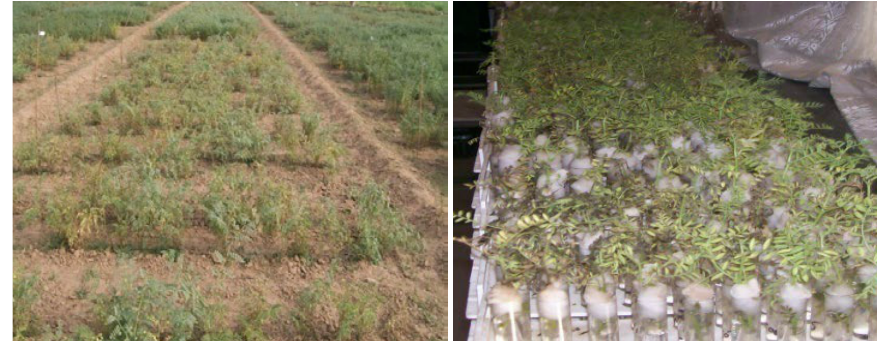
Figure 2. Figure showing screening of wild Cicer accessions under field conditions and laboratory